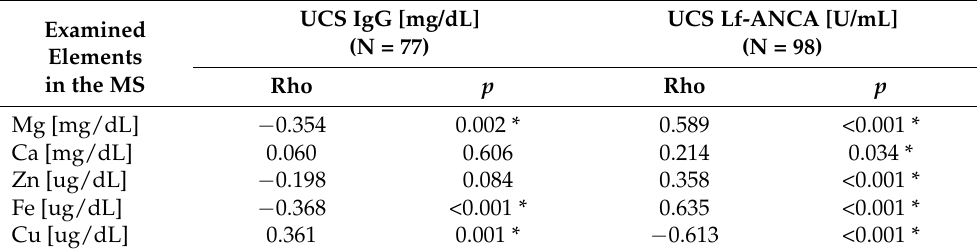
Table 3. Spearman’s correlation between the concentration of macro- and microelements in the MS and the concentration of IgG antibodies and Lf-ANCA auto-antibodies in the UCS of newborns.